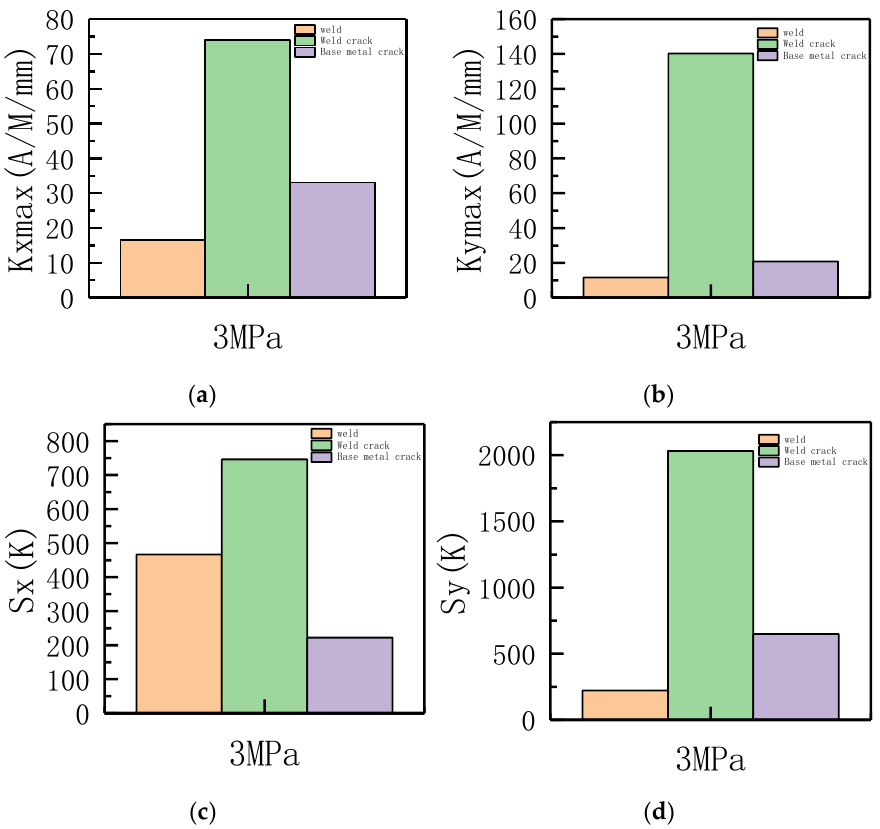
Figure 23. Variations of Kmax and S(K) parameters at 3 MPa. ( a ) Axial component of Kmax ; ( b ) radial component of Kmax . ( c ) Axial component of S ( k ); ( d ) radial component of S ( k ).